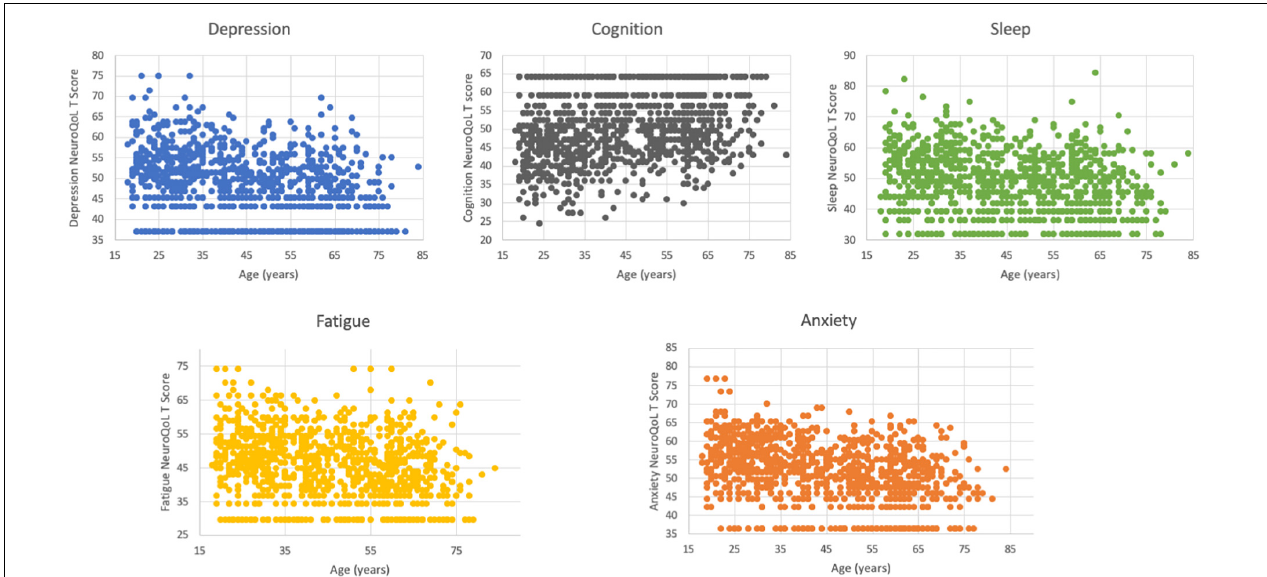
FIGURE 4 | Distribution of Neuro-QoL T-scores by age. There is a suggestion of a bimodal peak in worse depression, cognitive and sleep score with peaks around ages 30–35 and again around ages